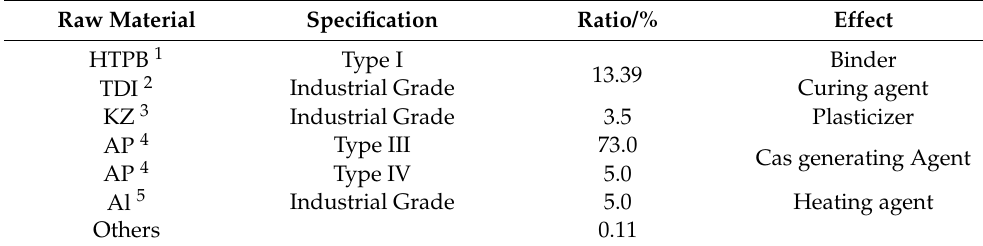
Table 1. Composition of high-energy gas fracturing agent.